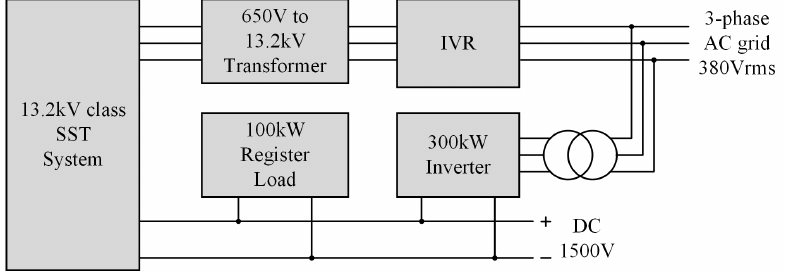
Figure 11. Experimental configuration of a 13.2 kV class 3-phase solid state transformer.